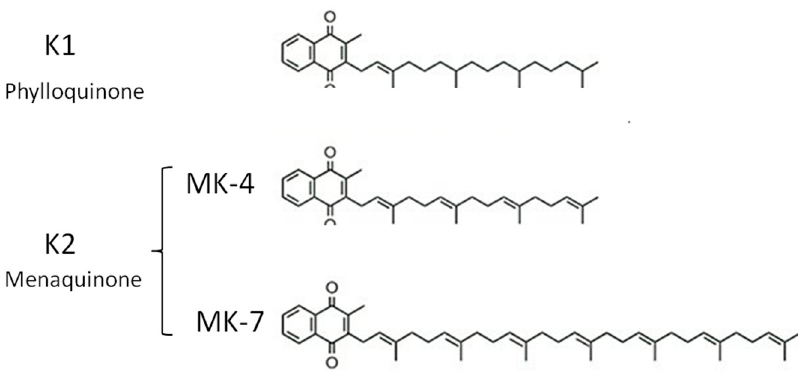
Figure 1. K structures. MK4 and MK7 are the major forms of K2 present in the diet.